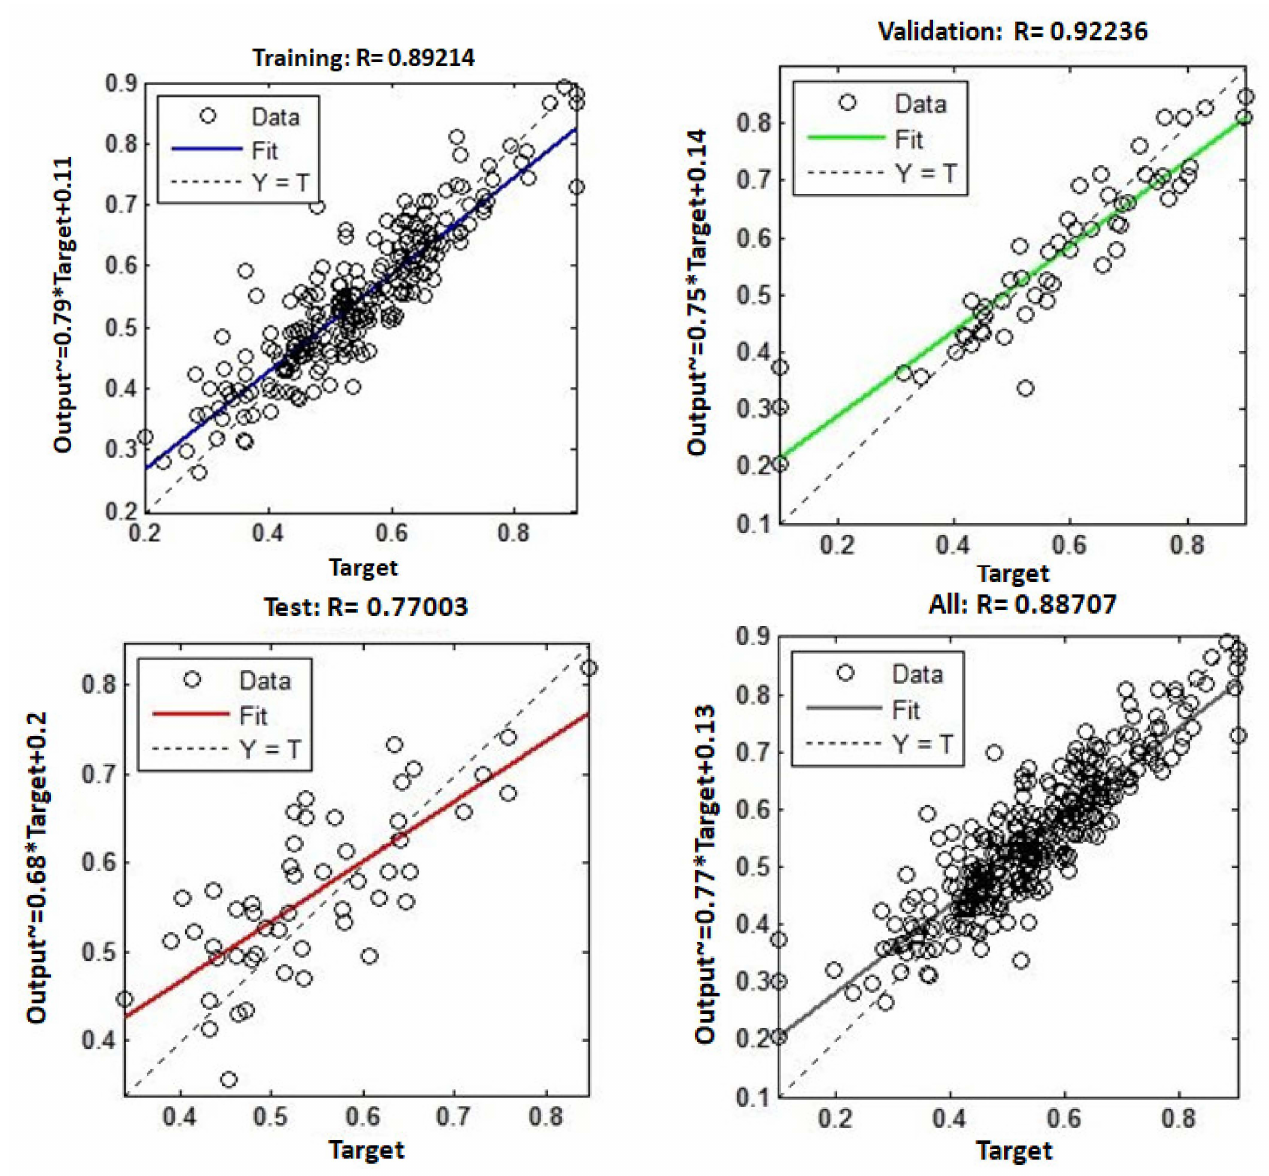
Figure 11. Regression graph of network 4-2-3 for angular distortion with time gap between two, three and four